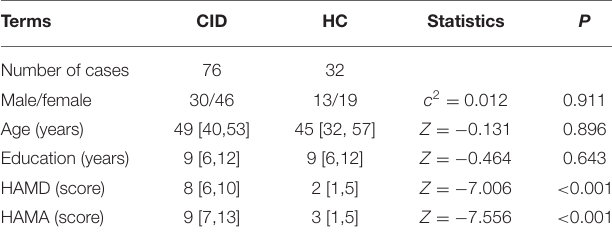
TABLE 1 | Demographic data and HAMD and HAMA